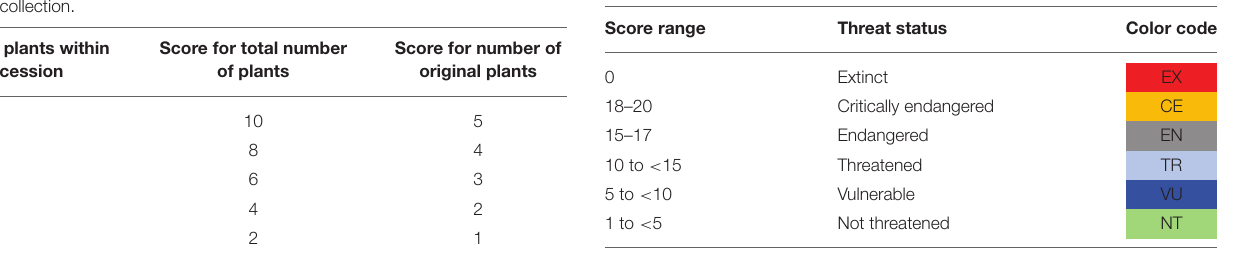
TABLE 2 | Score range for different threat